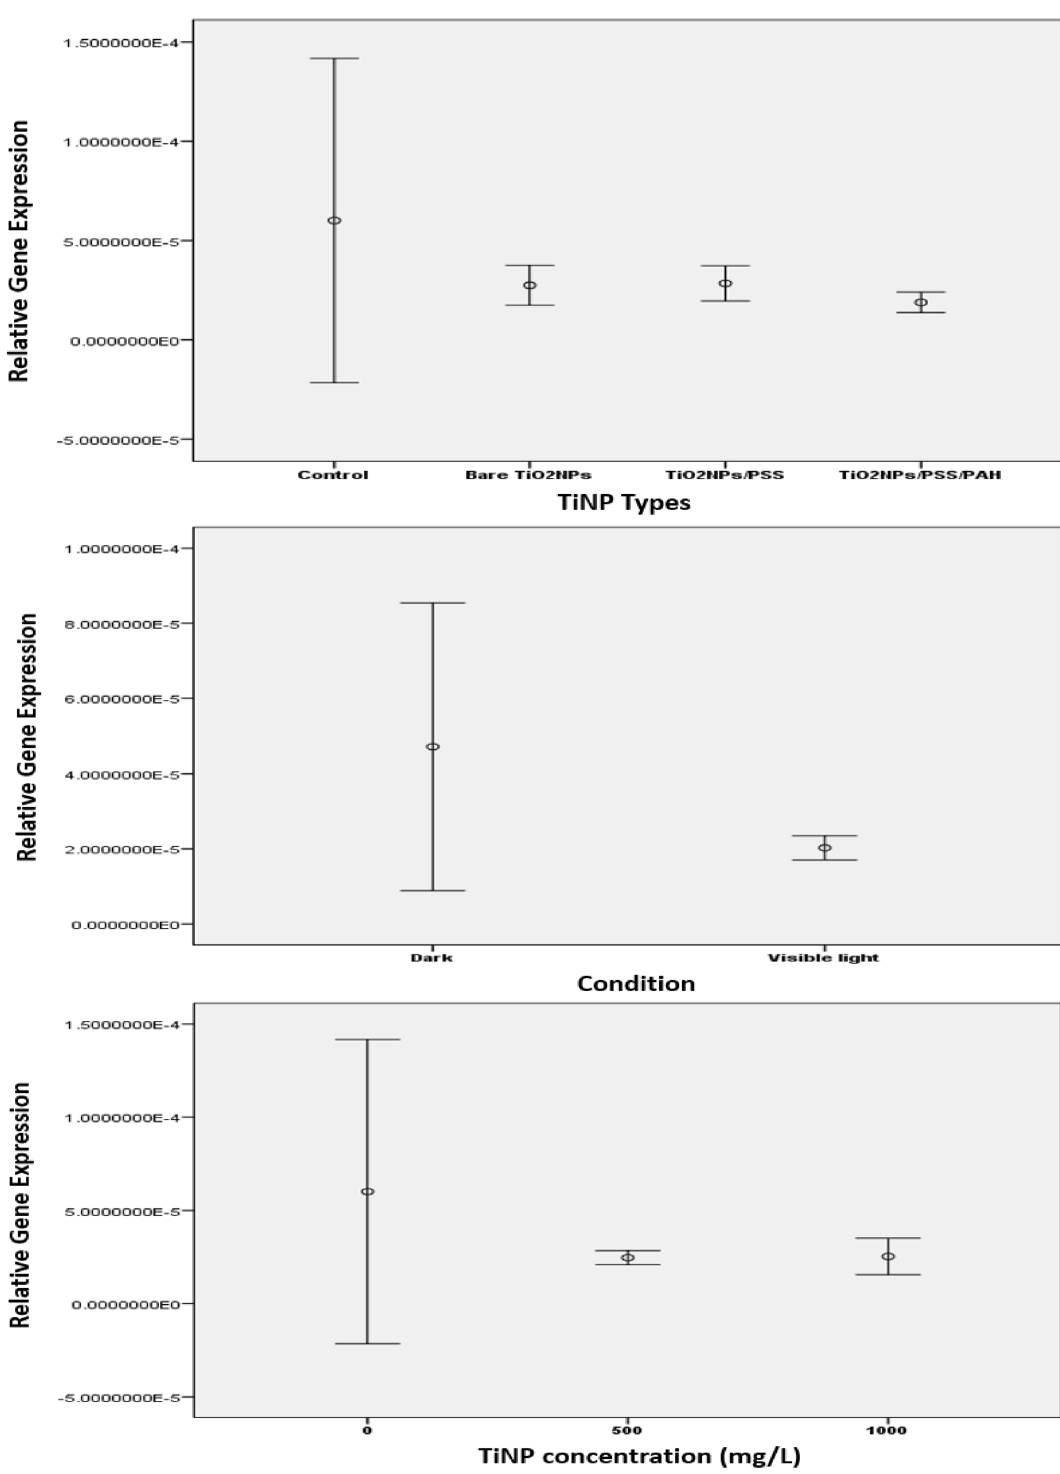
hpf, n = 10) following exposure to TiO NPs with various coatings, 2 concentrations and dark/light